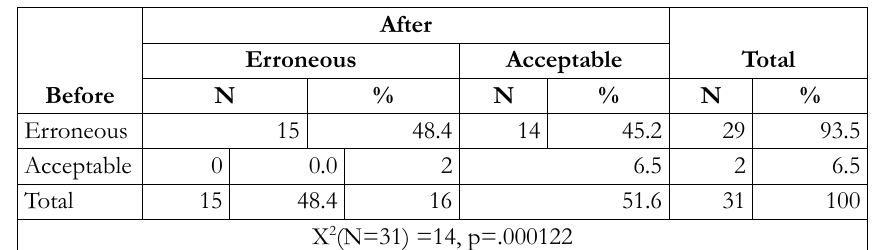
Table 8. Definitions of analogy before and after